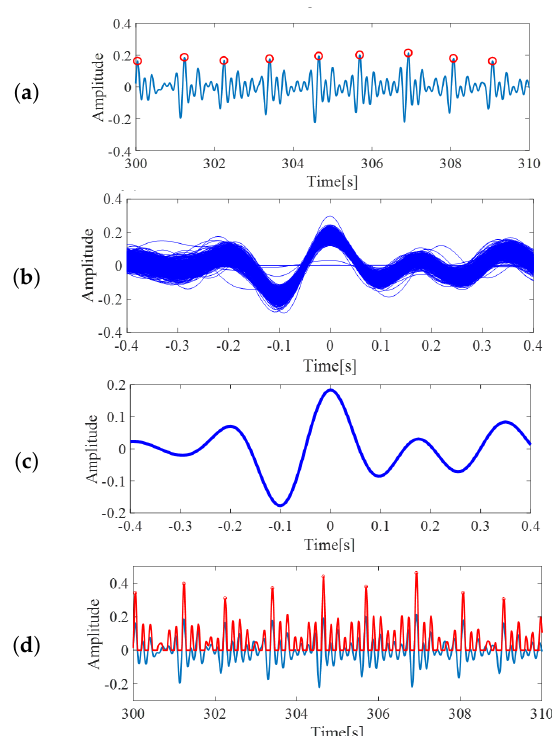
Figure 5. ( a ) The red circles are local maxima from BCG inputs, from the template creation step. ( b ) The extracted segments, which were assumed to represent BCG wave form. ( c ) BCG template created by averaging the extracted segments. ( d ) The correlation coefficients of pre-processed BCG and the template. Value of correlation becomes high around BCG peaks. These peaks are defined as